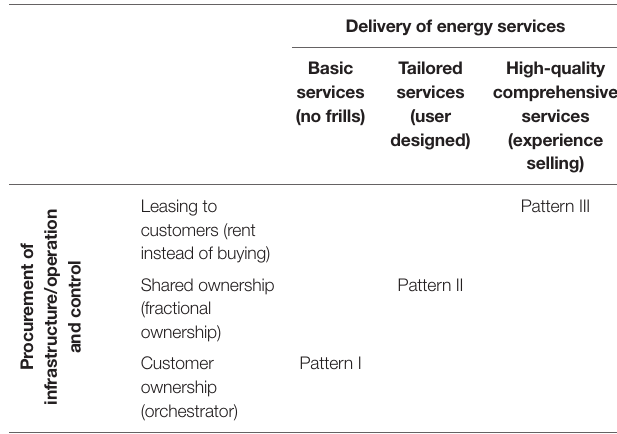
TaBle 1 | The business model reference patterns within the business model solution space (Facchinetti and sulzer,